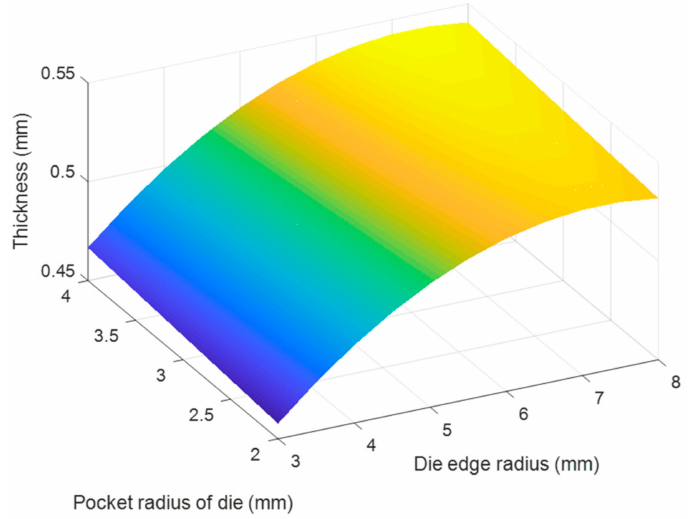
Figure 23. The effect of punch nose radius and pocket radius of die on stress.